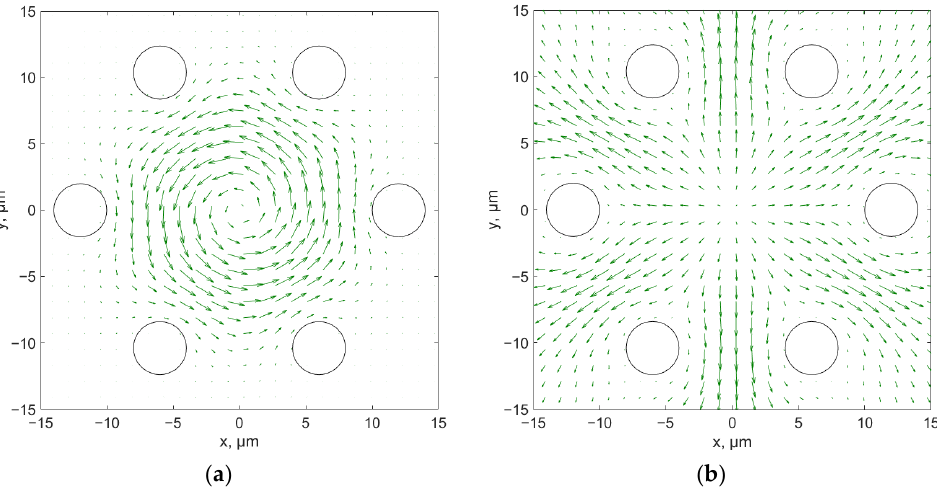
Figure 10. Spin ( a ) and orbital ( b ) parts of the transverse component of the Poynting vector of the fundamental core mode of an HF with the same geometric parameters as for ASBGF in the case of circular polarization. The calculation was made at a wavelength of 1 µm.